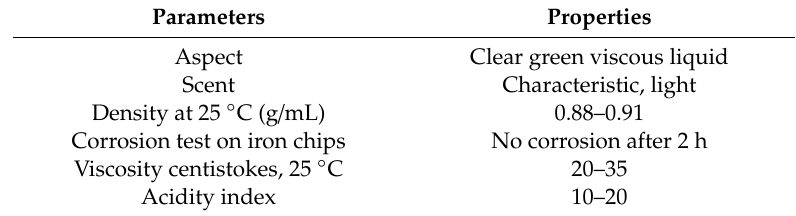
Table 4. Characteristics of the cutting fluid used (provided by QUIMATIC /